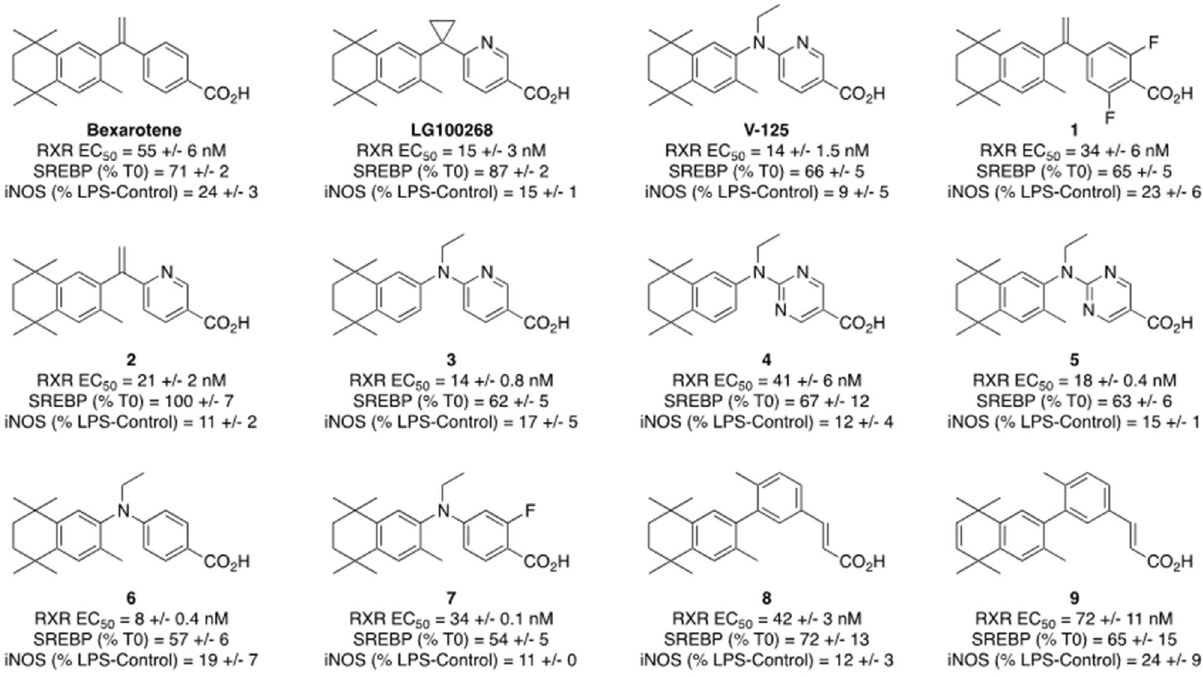
Figure 1. Structures and activities of bexarotene, LG100268, V-125 and nine rexinoids evaluated by PCA. Bexarotene is approved to treat cutaneous T-cell lymphoma, and V-125 was identified as a promising novel rexinoid based on its activity in published in vitro assays 30 . The iNOS suppression in RAW 264.7 cells was determined by cell treatment with 100 nM rexinoid followed by challenge with 1 ng/mL LPS over 24 h. Griess assay measured NO production normalized to LPS-stimulated control. SREBP and RXR activation were assessed as reported in prior work 30 . T0 is T0901317, a known LXR agonist and activator of